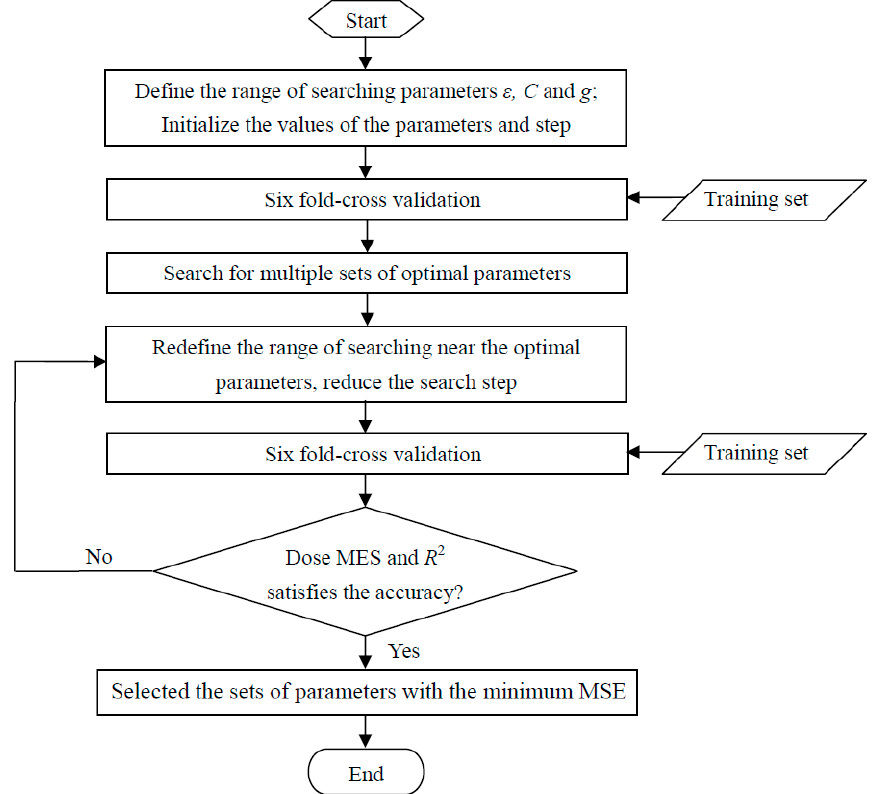
Figure 11. Flow chart of the grid search algorithm.